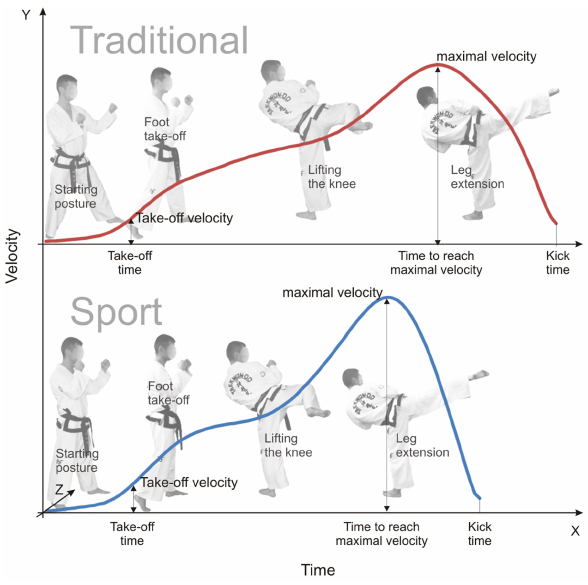
Fig. 1. Example graphs of foot marker velocity changes in time in both analysed versions—sport (red line) and tradi- tional (blue line) with division for movement